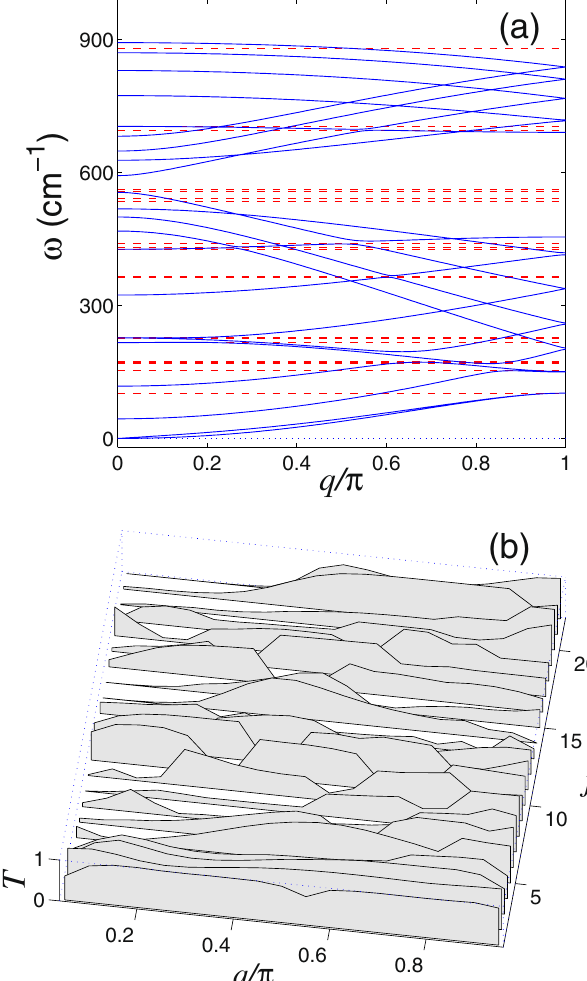
Figure 8. Dispersion curves ( N e in total) of the out-of-plane oscillations of an armchair nanoribbon. Number of atoms in the elementary cell is N e = 22. ( b ) Transmission coefficient T vs. wavenumber q for each dispersion curve ( j stands for the sequential number of a dispersion curve) for phonons scattered by the double vacancy V 2 (585). The average transmission coefficient of such phonons is = . T 0 533 . Horizontal dashed straight lines mark the eigenfrequencies out-of-plane localized vibrations of the defect.